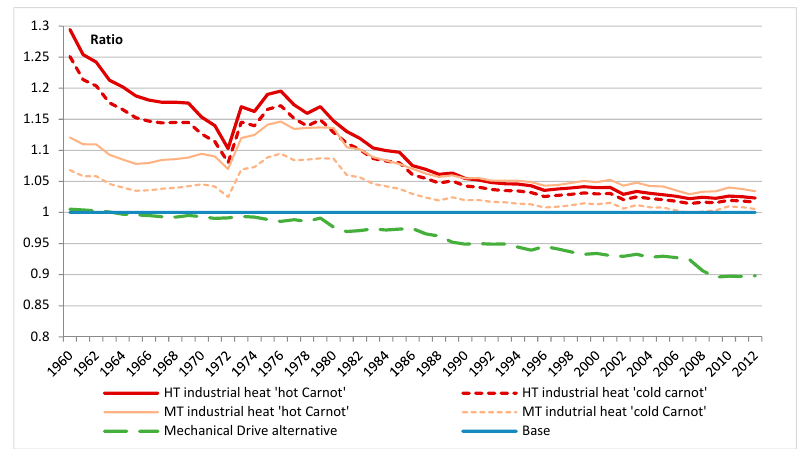
Figure 13. National useful exergy consumption under alternative end-use efficiency methods, normalised to useful exergy consumption under base methods.